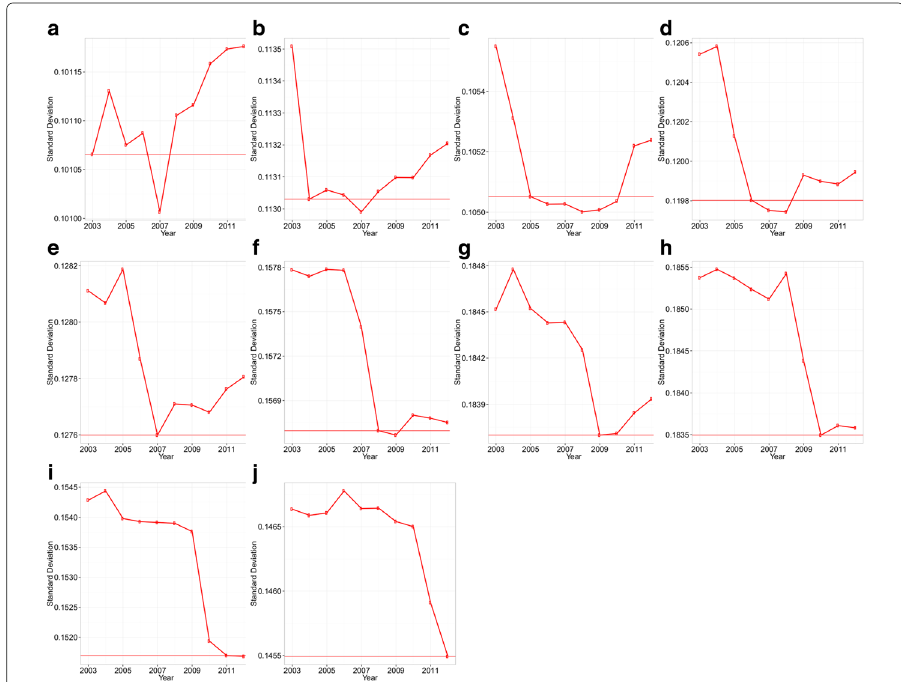
Fig. 4 Standard deviation of each y neg s for years 2003 to 2012. The horizontalredline denotes the standard t (cid:2) | t deviation in the year analyzed (i.e., t ). a 2003; b 2004; c 2005; d 2006; e 2007; f 2008; g 2009; h 2010; i